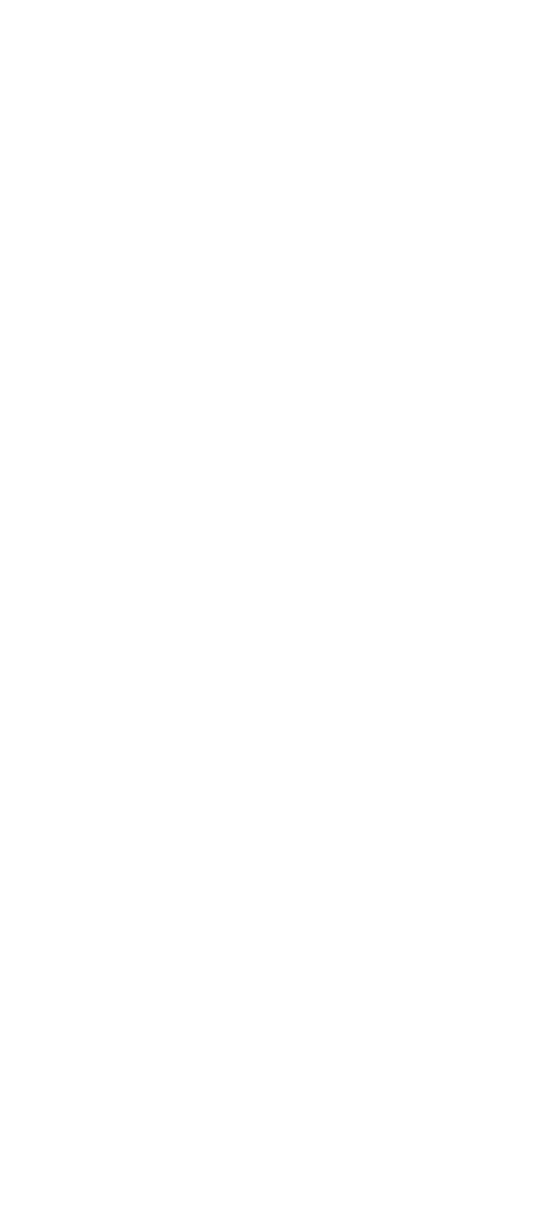
forceps major, left SLF, bilateral ILF and inferior fronto-occipital fasciculus (IFOF). The color scale indicates the degree of overlap among subjects. L,